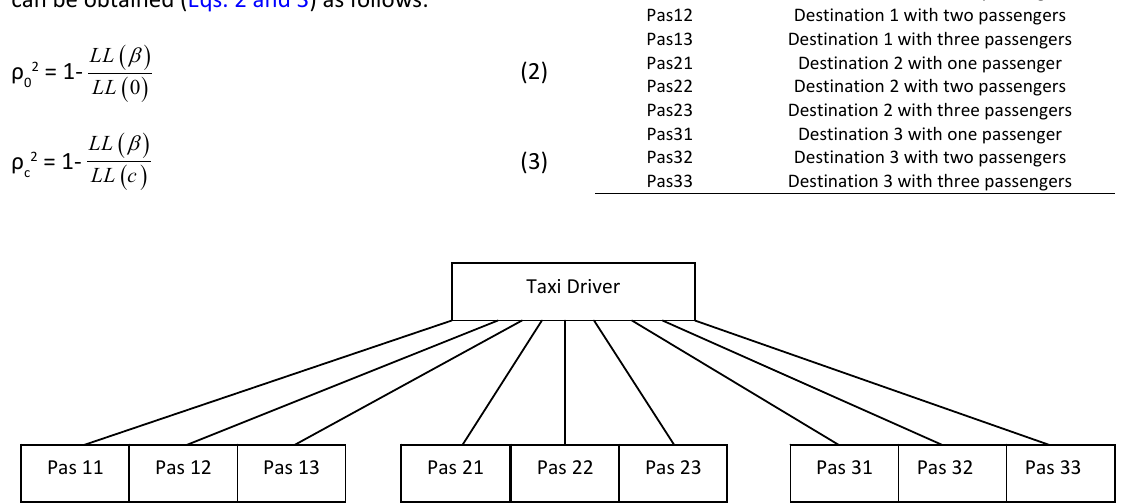
Fig. 1: Structure of multinomial logit model Fig. 1. Structure of multinomial logit model